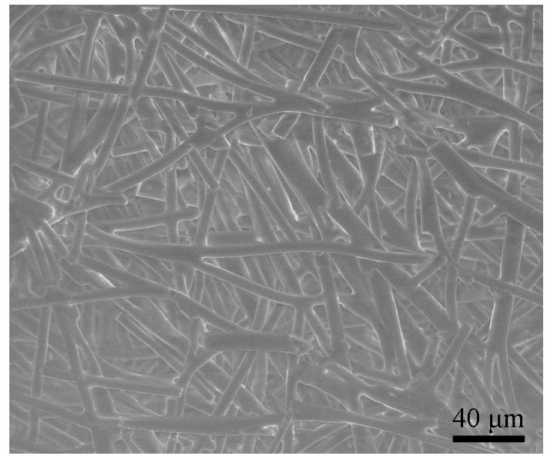
Figure 1. Schematic of a scanning electron microscope (SEM) image for the RF bulk material viewing, along the through-the-thickness (TTT) direction.